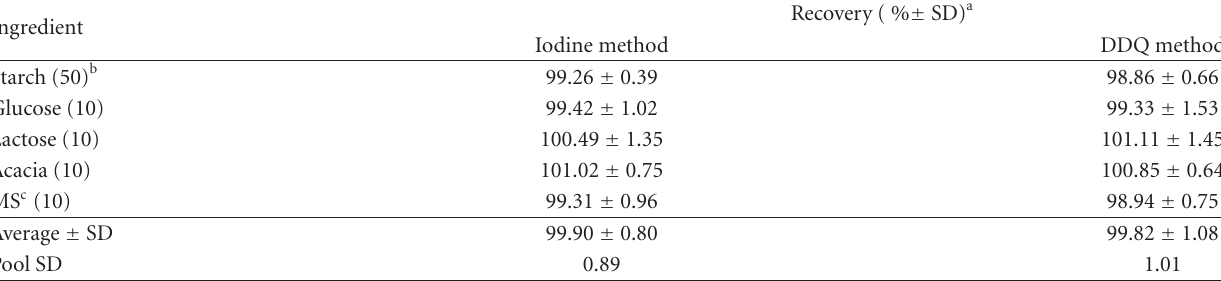
Table 6: Determination of OMZ in presence of common excipients by the proposed fixed time methods.